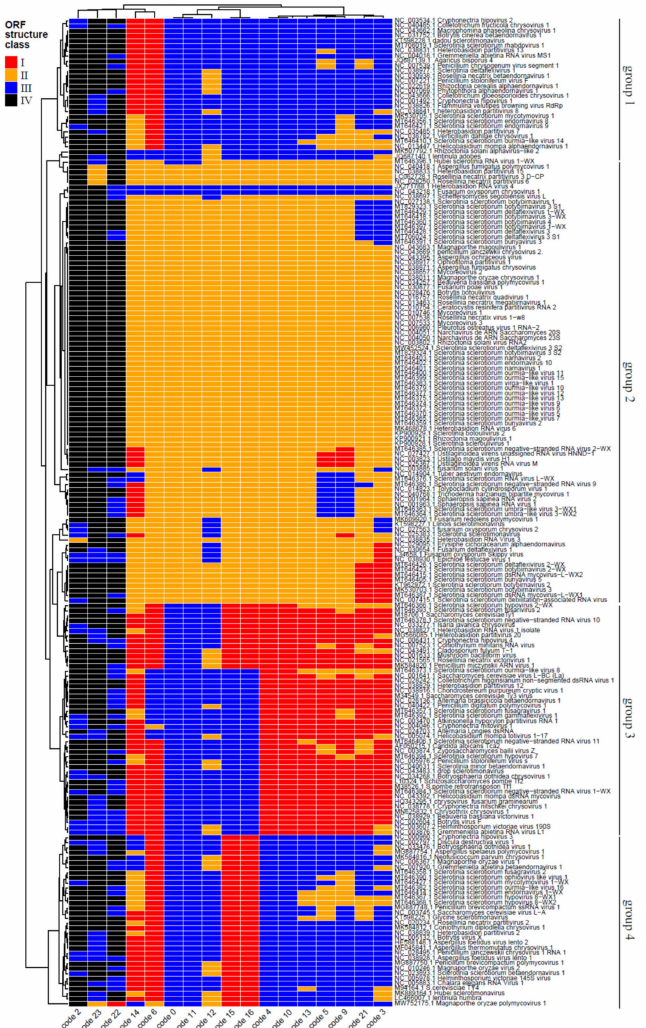
Figure 3. Hierarchical clustering of mycoviral sequences based on the profile of genetic code usage. The ORF structure class legend indicates: I = If the size of the ORF generated by the genetic code is greater than or equal to the size predicted by the standard (1) genetic code, and shows conserved domain; II = If the size of the ORF generated by the genetic code is greater than or equal to the size predicted by the standard (1) genetic code, and lack conserved domain; III = If the size of the ORF generated by the genetic code is smaller than or equal to the size predicted by the standard (1) genetic code, and show a conserved domain; IV = If the size of the ORF generated by the genetic code is smaller than the size predicted by the standard (1) genetic code, and lack conserved